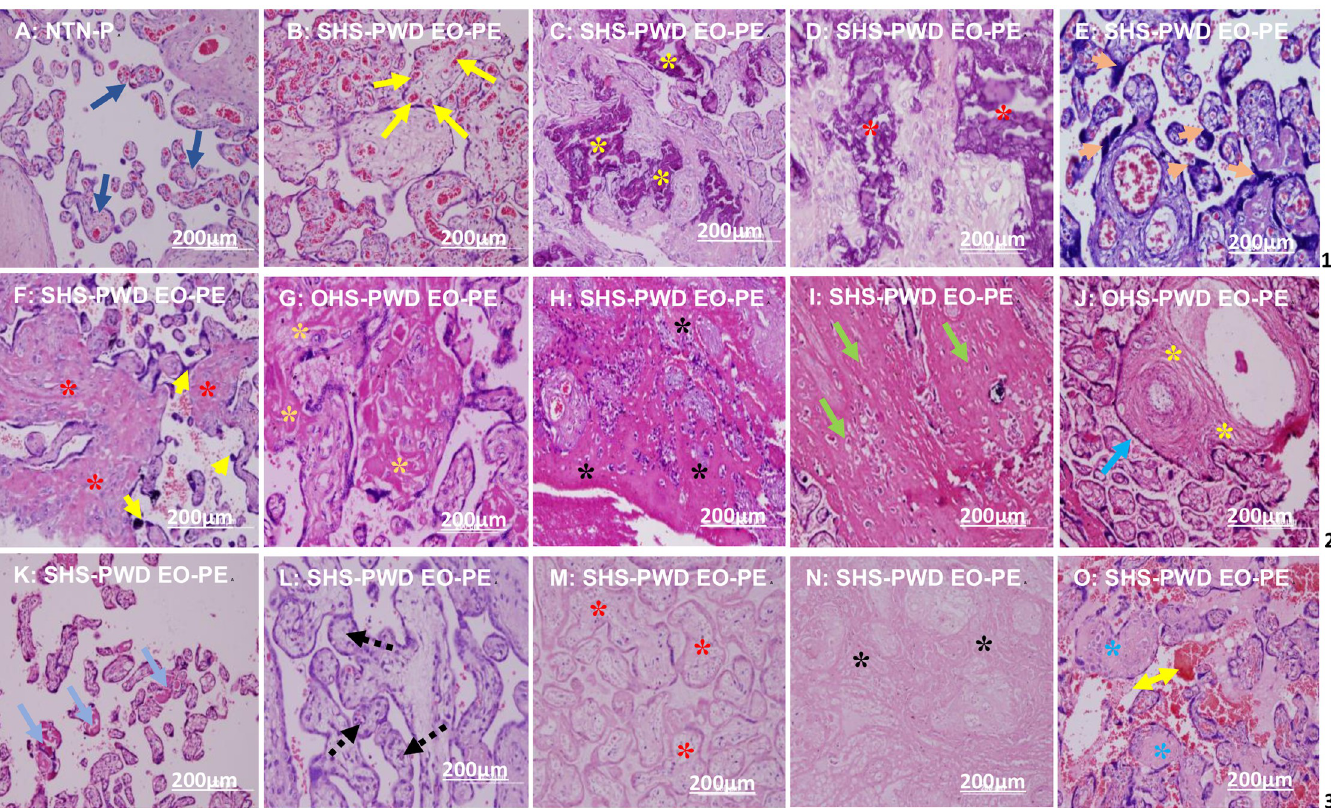
Fig 2. Photomicrographs of placental villi of SHS and OHS-PWD EO-PE and LO-PE compared to NTN-P. A: Normal villi (deep blue arrows, row 1) of NTN-PW at 38 weeks (x20 magnification). B: Extensive chorangiosis (yellow arrows, row 1) in SHS-PWD EO-PE at 32 weeks (x20 magnification). C: massive intervillous (yellow asterisks, row 1) (x20) and D: intravillous calcifications (red asterisks, row 1) (x20 magnification) SHS-PWD EO-PE at 32 weeks. E: massive syncytial knots formation with few fibrins (orange arrowhead) in SHS-PWD EO-PE at 32 weeks (x20 magnification). F: massive intravillous fibrin (red asterisks, row 2) with few syncytial knot formations (yellow arrowhead, row 2) in SHS-PWD EO-PE at 32 weeks (x20 magnification). G: Perivillous fibrin deposition (gold asterisks, row 2) in OHS-PWD EO-PE at 33 weeks (x20). H: extensive perivillous fibrin deposition (black asterisks, row 2) SHS-PWD EO-PE at 32 weeks (x20 magnification). I: extensive extravillous with few areas of infarction (green arrows, row 2) (x20) SHS-PWD EO-PE. J: Large stem villi (sea blue arrow) with extensive fibrin deposition (yellow asterisk, row 2) in OHS-PWD EO-PE at 33 weeks (x20). K: distal villous hypoplasia with few thromboses (blue arrows, row 3) in SHS-PWD EO-PE at 33 weeks (x10 magnification). L: empty capillaries devoid of red blood cells (black line arrows, row 3) in SHS-PWD EO-PE (x20 magnification). M: extensive villous infarction (red asterisk, row 3) in SHS-PWD EO-PE at 32 weeks (x20 magnification). N: extensive fibrinoid necrosis with infarction (black asterisk) in SHS-PWD EO-PE at 32 weeks (x20 magnification). O: Massive intervillous haemorrhage (yellow double arrows) with few avascular villi (sea blue asterisks) in SHS-PWD EO-PE at 32 weeks (x20). Scale bar = 200 μ m.